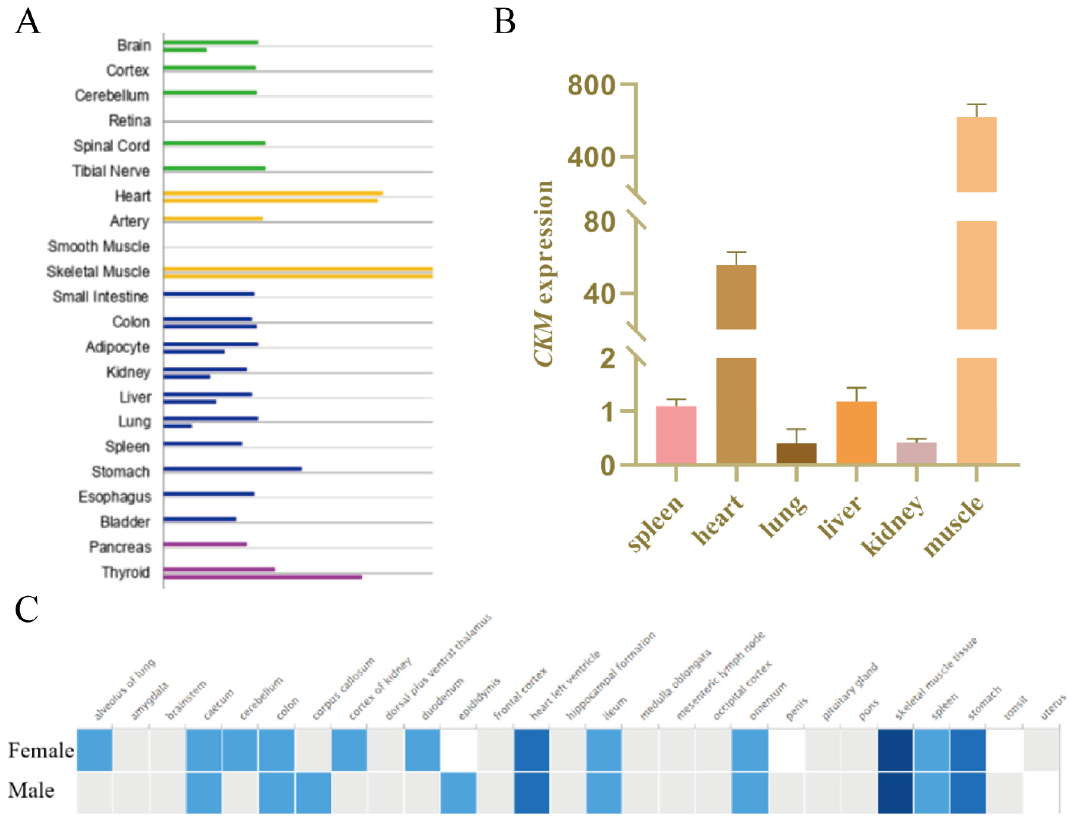
Figure 1. Expression of the CKM gene in different tissues of human and pig. ( A ) Gene Cards database analysis shows that the CKM gene expression level is higher in skeletal muscle and myocardium. ( B ) Quantitative Real-time PCR to detect the expression of the CKM gene in pig heart, liver, spleen, lung, kidney and muscle tissues. ( C ) Expression Atlas database analyzes the expression of the CKM gene in boars and